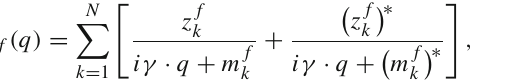
Fig. 4 Comparison of σ b s ( q 2 η ) and Δσ b s ( q 2 η ) for the b -quark on the complex plane ( P 2 = − m 2 η plane in the left-hand panel of Fig. 3, where the maximal hadron mass that can be reached is m max